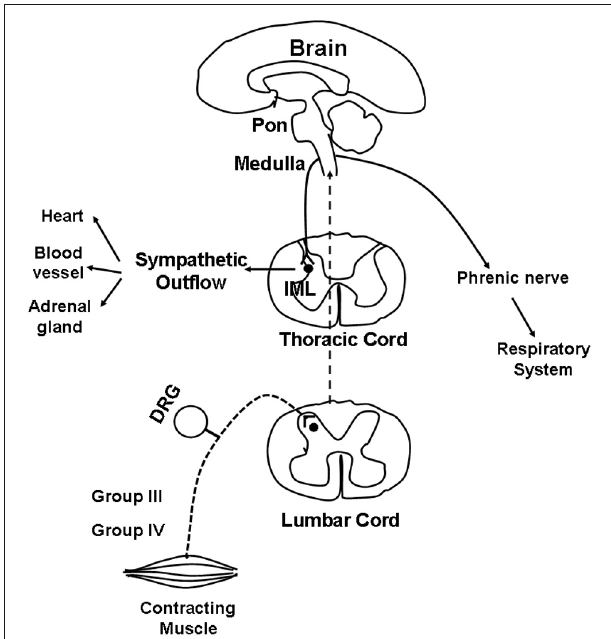
FIGURE 1 | Schematic illustrating the proposed pathway for the reflex cardiovascular and respiratory changes evoked by skeletal muscle contraction. Dashed lines indicate the afferent limb of this reflex pathway whereas solid lines points out the efferent limb. See text for additional